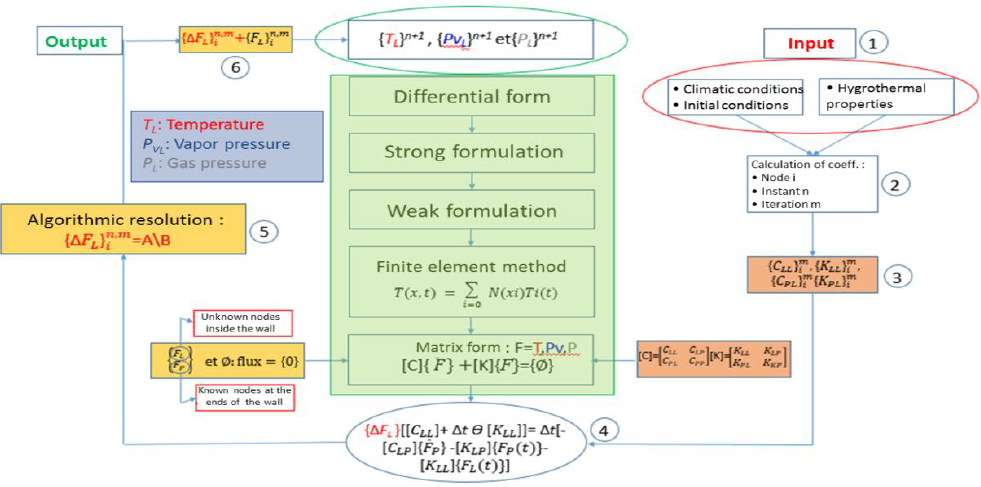
Figure 3. Algorithm for resolution of the transfer equations.